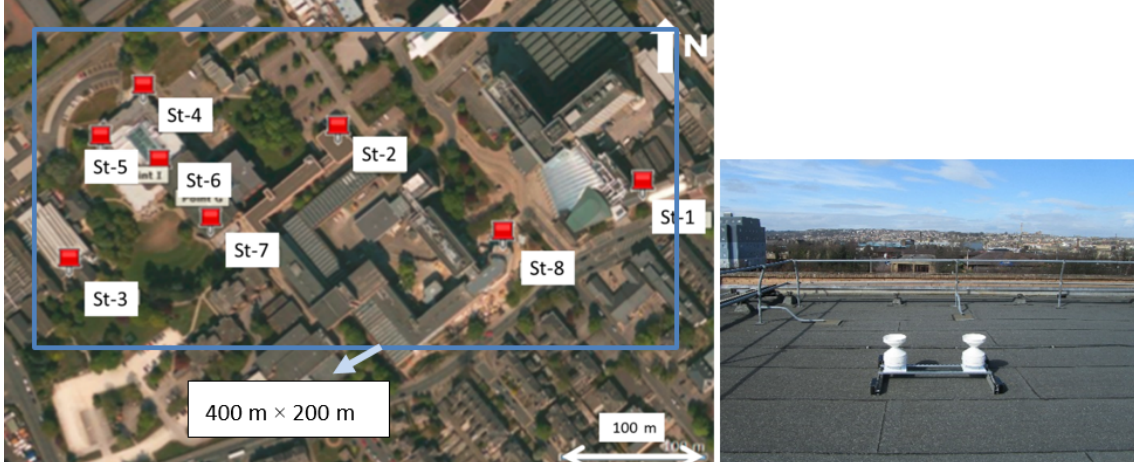
Figure 1. Left: aerial view of rain gauge network covering an area of 400m × 200m at Bradford University, UK. Right: a photograph of paired rain gauges at station 6.